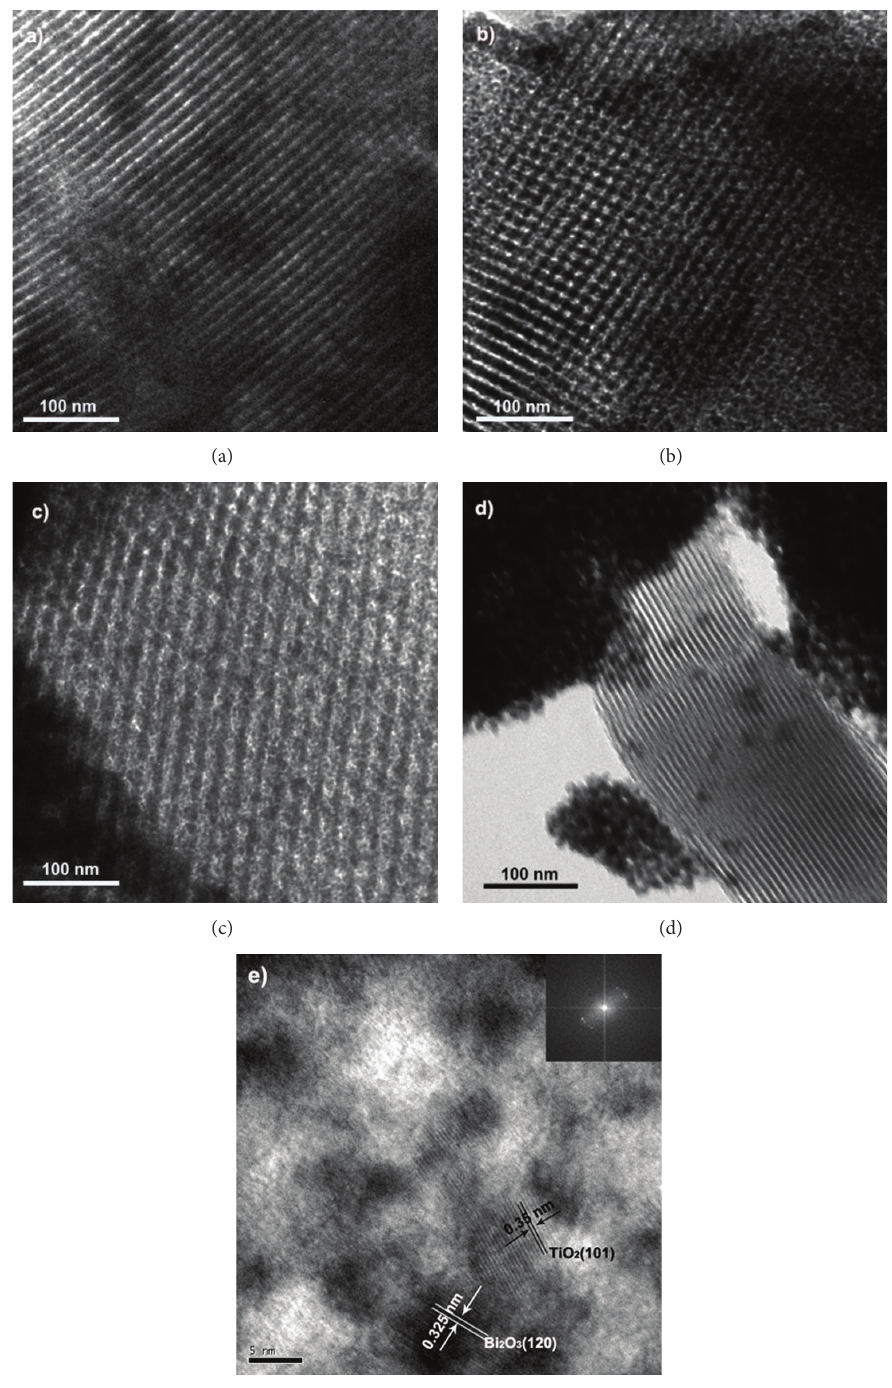
Figure 3: TEM images of Bi-TiO 2 /SBA-15: (a) Bi-TiO 2 /SBA-15(400), (b) Bi-TiO 2 /SBA-15(550), (c) Bi-TiO 2 /SBA-15(700), (d) Bi-TiO 2 /SBA- 15(850), and (e) HRTEM image of Bi-TiO 2 /SBA-15(550) (inset is the corresponding FFT pattern).